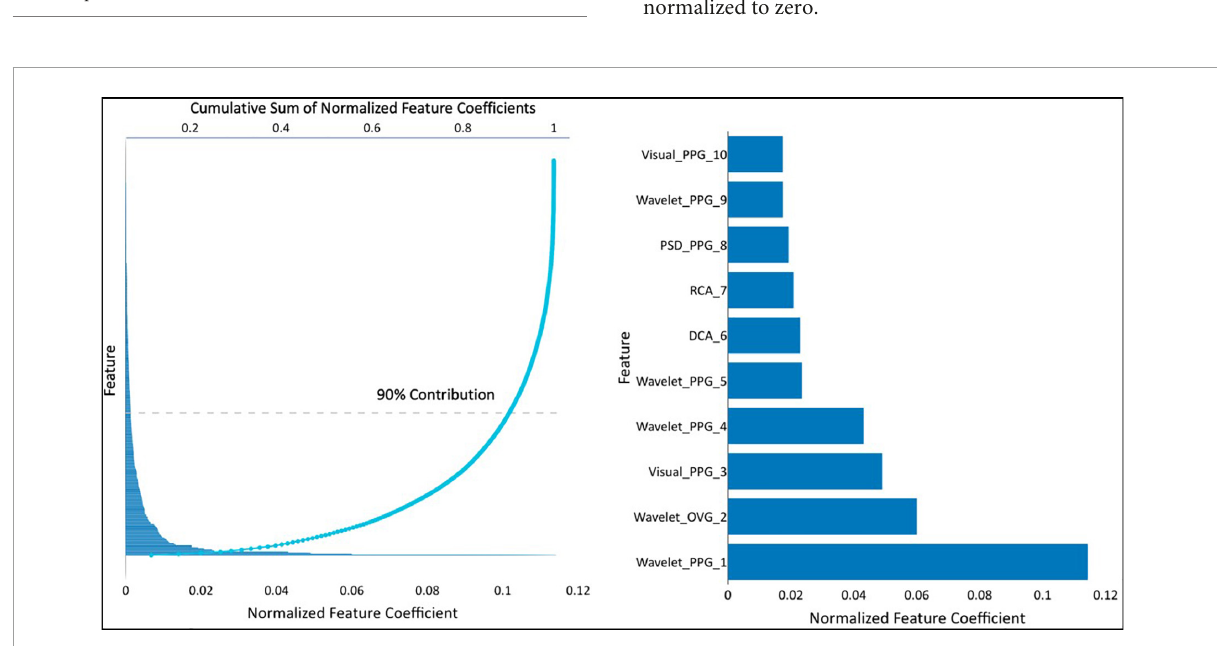
FIGURE2 (Left) feature coefficients normalized by feature averages and its cumulative sum, and (right) the normalized feature coefficients for the top 10 features. Visual-PPG — features derived from analyzing the PPG and its first and second derivatives in phase space. Wavelet-PPG — features derived from wavelet analysis of PPG signal. PPG-PSD — features deviates from power spectral density analysis of the PPG signal. RCA, repolarization conduction abnormality; analysis of the ventricular repolarization waveform in band-pass limited frequency ranges. DCA, depolarization conduction abnormality; analysis of the ventricular depolarization waveform in band-pass limited frequency ranges. Wavelet-OVG — features derived from wavelet analysis of OVG